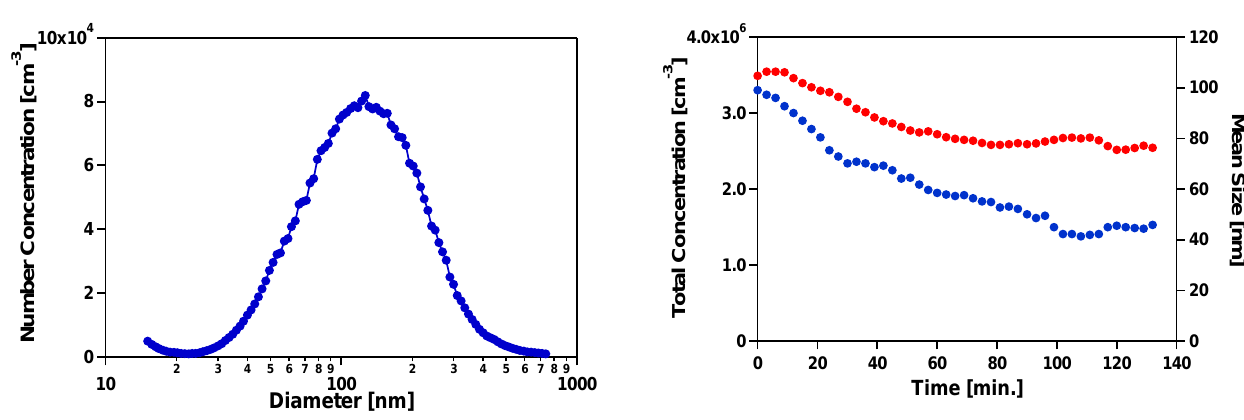
Fig. 2. Typical dry size distribution of aerosols generated by at- omizing the Ca(HCO 3 ) 2 solutions with a TSI3076 constant output Figure 2. Typical dry size distribution of aerosols generated by atomizing the Ca(HCO 3 ) 2 nebulizer. The aerosols were dried to RH < 5% in a diffusion drier solutions with a TSI3076 constant output nebulizer. The aerosols were dried to RH < 5% in a using Silica gel as desiccant. diffusion drier using Silica gel as desiccant.